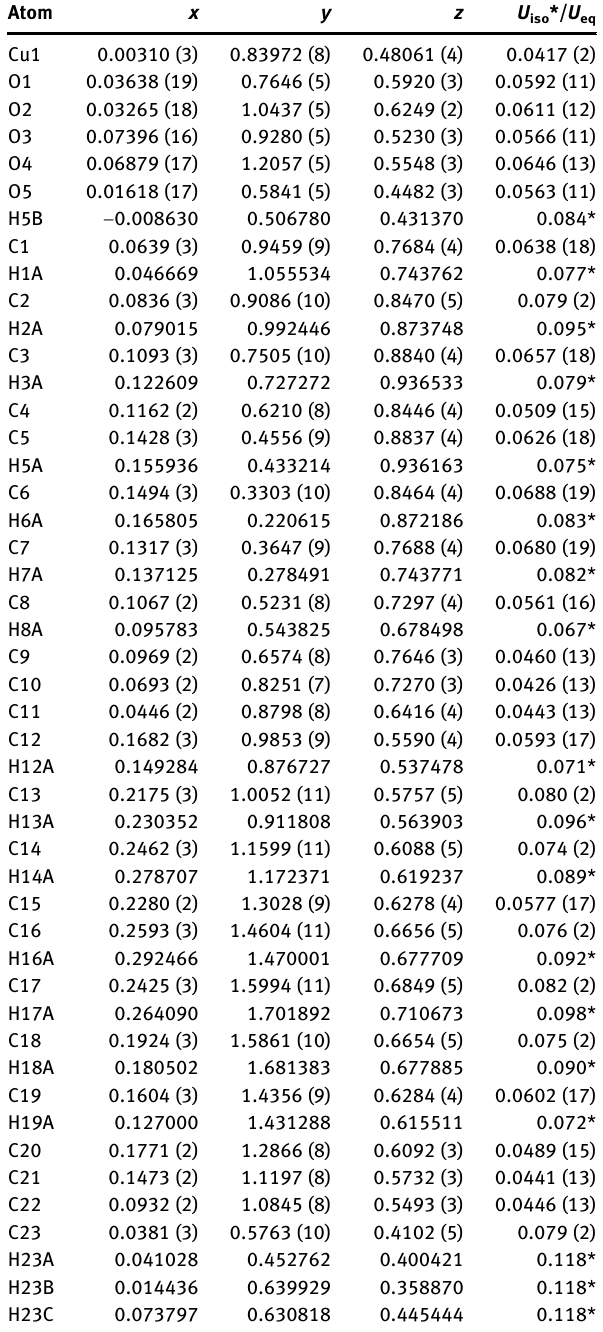
Table  : Fractional atomic coordinates and isotropic or equivalent isotropic displacement parameters (Å 